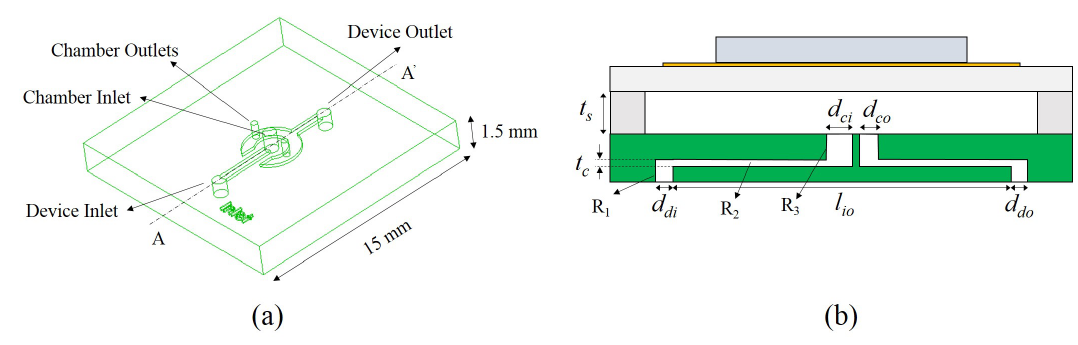
Figure A2. ( a ) Transparent view of the microchannels: Internal channels are visible. The microchannel part is large (15mm) to enable easy manual handling. ( b ) Cross-section of microchannels along A-A’ with spacer and microactuator: Design parameters are spacer thickness ( t s ), device inlet diameter ( d di ), device outlet diameter ( d do ), distance between device orifices ( l io ), chamber inlet diameter ( d ci ), chamber outlet diameter ( d co ), internal channel thickness ( t c ). Static resistances are represented as R i .